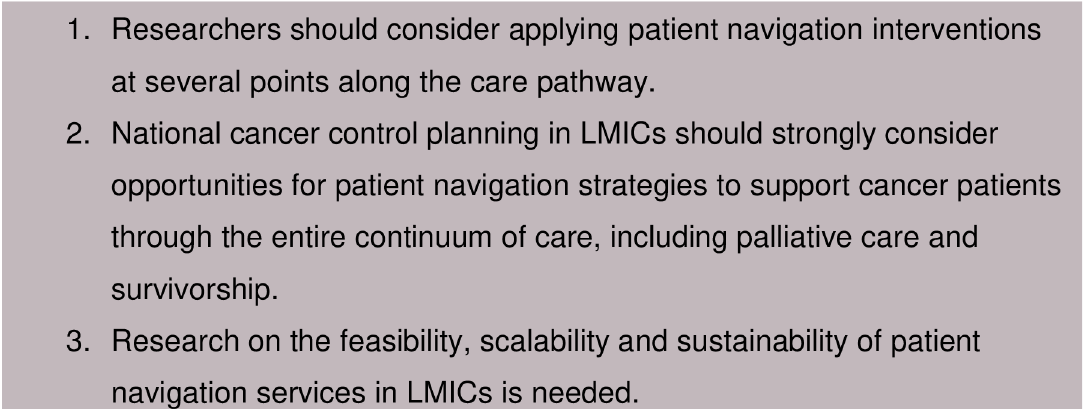
Fig 2. Recommendations for expanding patient navigation programs in